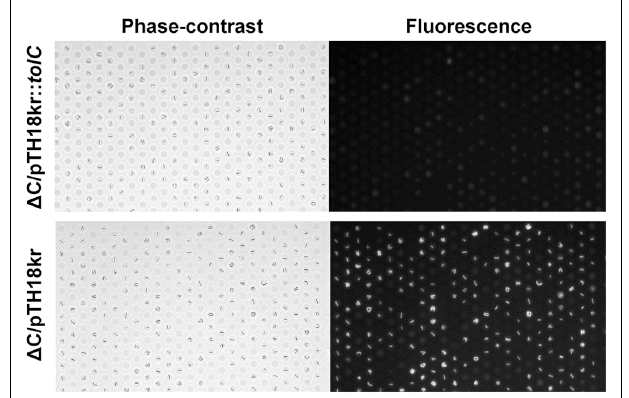
FIGURE 6 | Phenotypic change after genetic transformation. Phase-contrast (left) and fluorescence (right) images of E. coli (cid:2) C cells transformed with a vector expressing tolC from Salmonella enterica (pTH18kr::tolC; top) or a control vector pTH18kr (bottom).